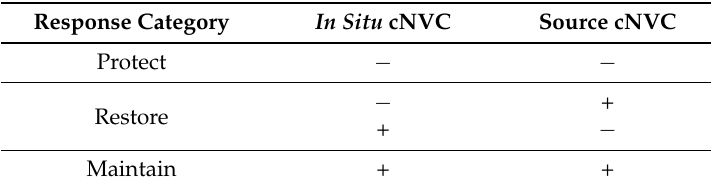
Table 3. Schema for assigning Potential wildland fire Operational Delineation (POD)-level response categories based on in situ and source risk